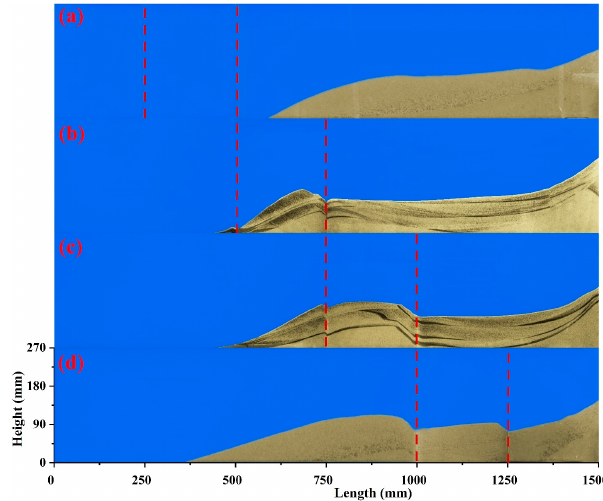
Figure 16. Snapshots of 70/140 mesh sand dunes in four channels at the stable status at Re = 3311 and θ = 90°, front view: ( a ) L 1 /L = 0.16; ( b ) L 1 /L = 0.33; ( c ) L 1 /L = 0.5; ( d ) L 1 /L = 0.66.